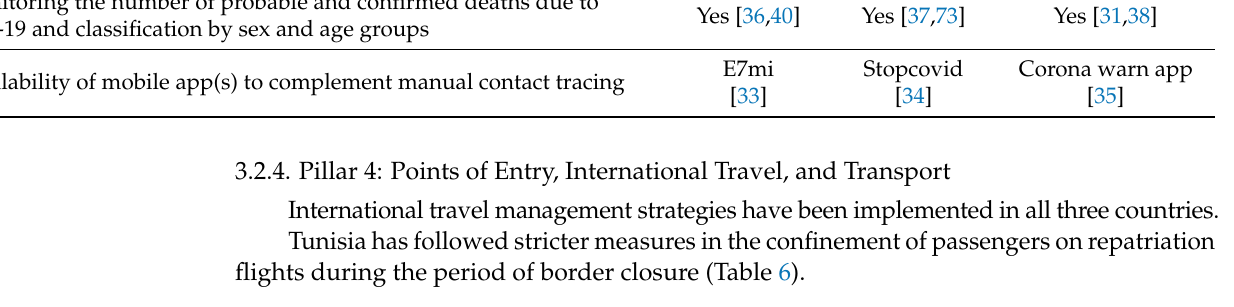
Table 6. Pillar 4: Points of entry (PoE), international travel, and transport.